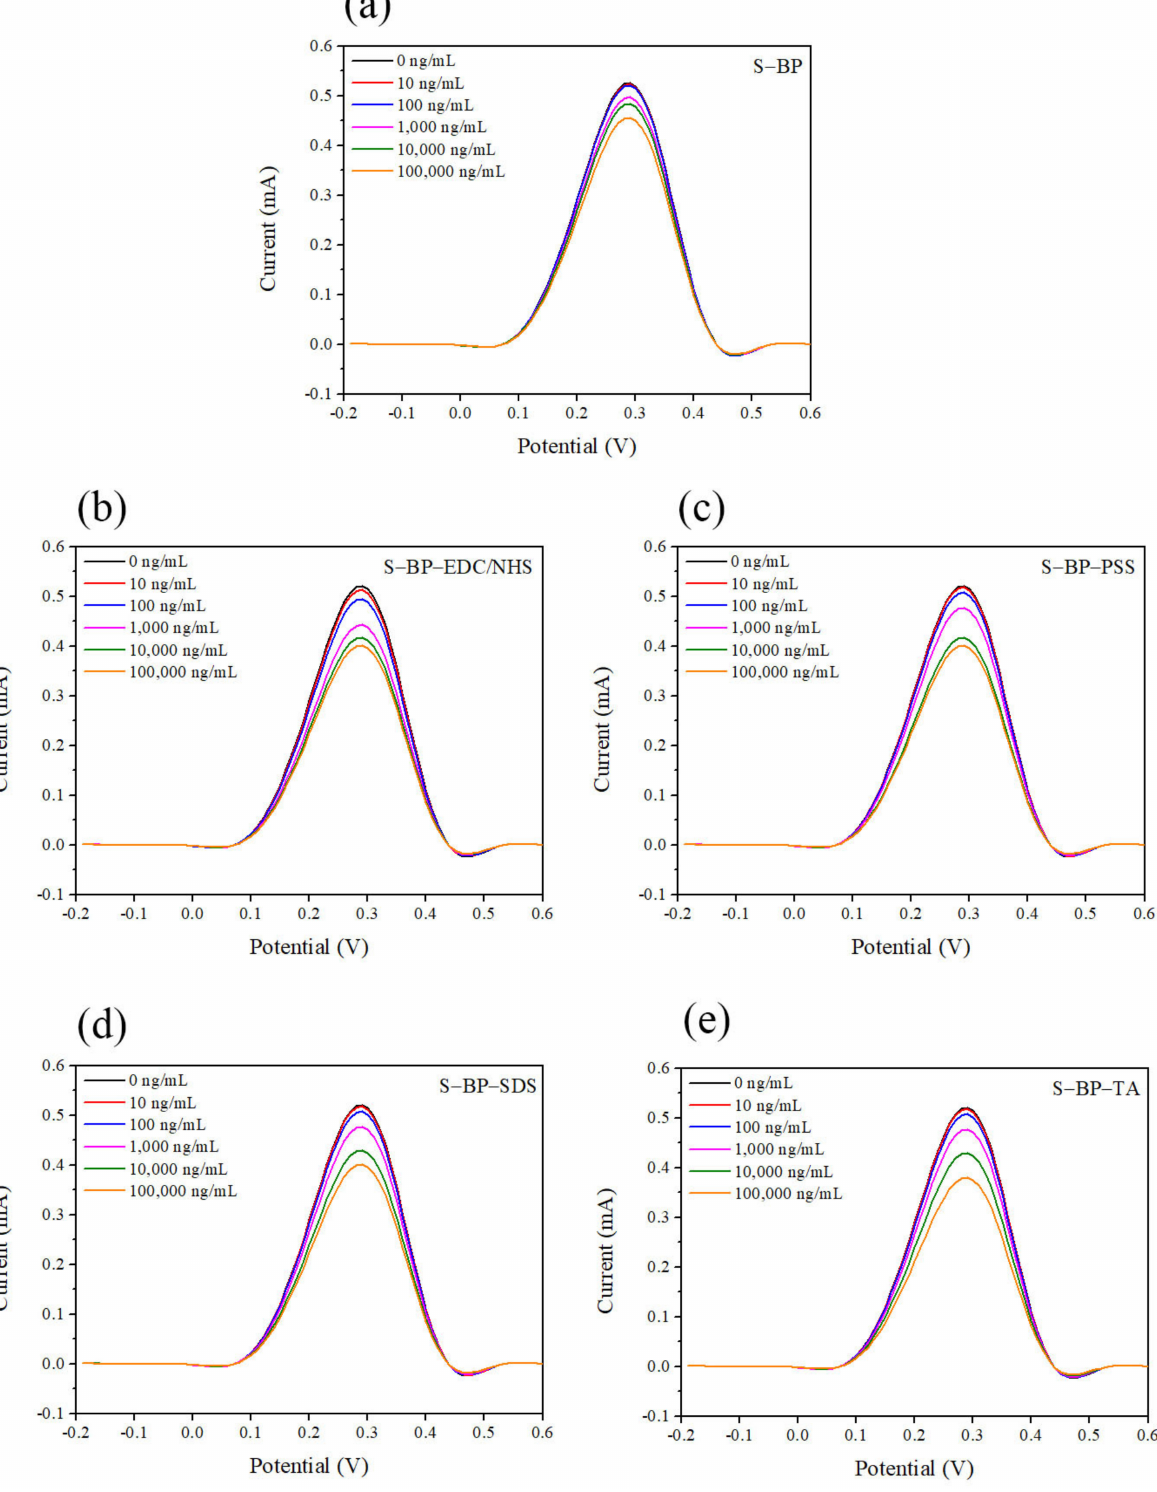
Figure 3. Differential Pulse Voltammetry (DPV) measurement of various specimens. ( a ) S–BP; ( b ) S–BP–EDC/NHS; ( c ) S–BP–PSS; ( d ) S–BP–SDS; ( e )